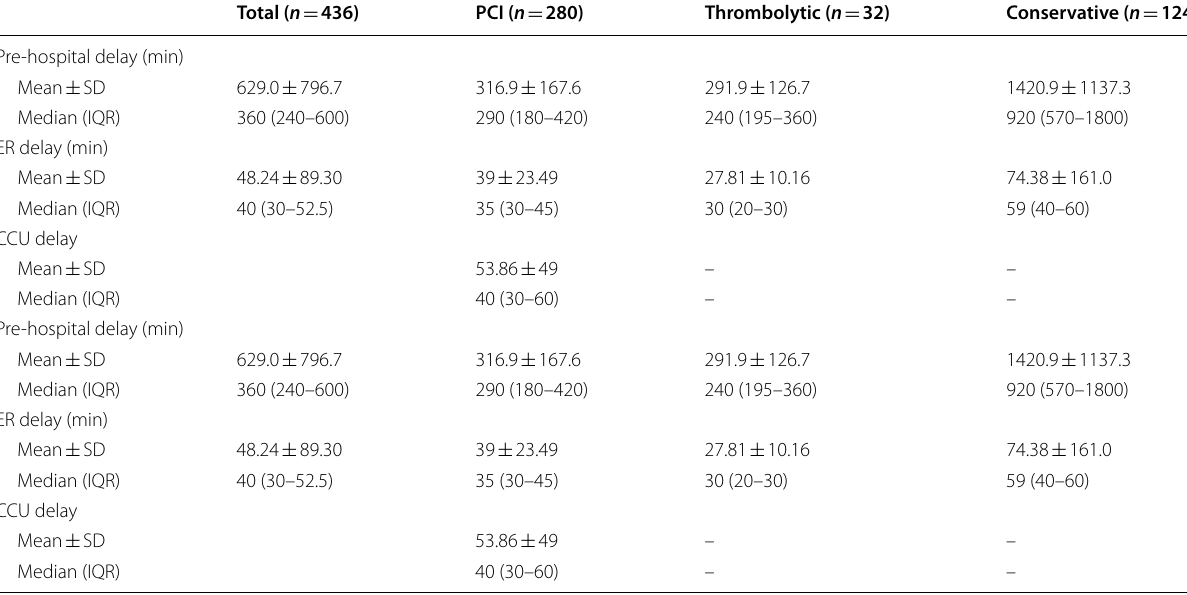
Tables 4 and 5 compare different types of management studied in this research based on risk factors and Killip Class on presentation and pre- and in-hospital delay times,